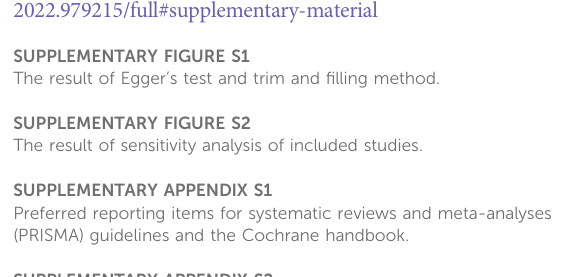
SUPPLEMENTARY FIGURE S1 The result of Egger ’ s test and trim and fi lling method. SUPPLEMENTARY FIGURE S2 The result of sensitivity analysis of included